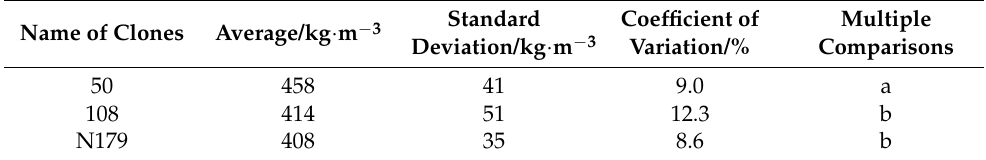
Table 2. Air dry density of poplar clones.